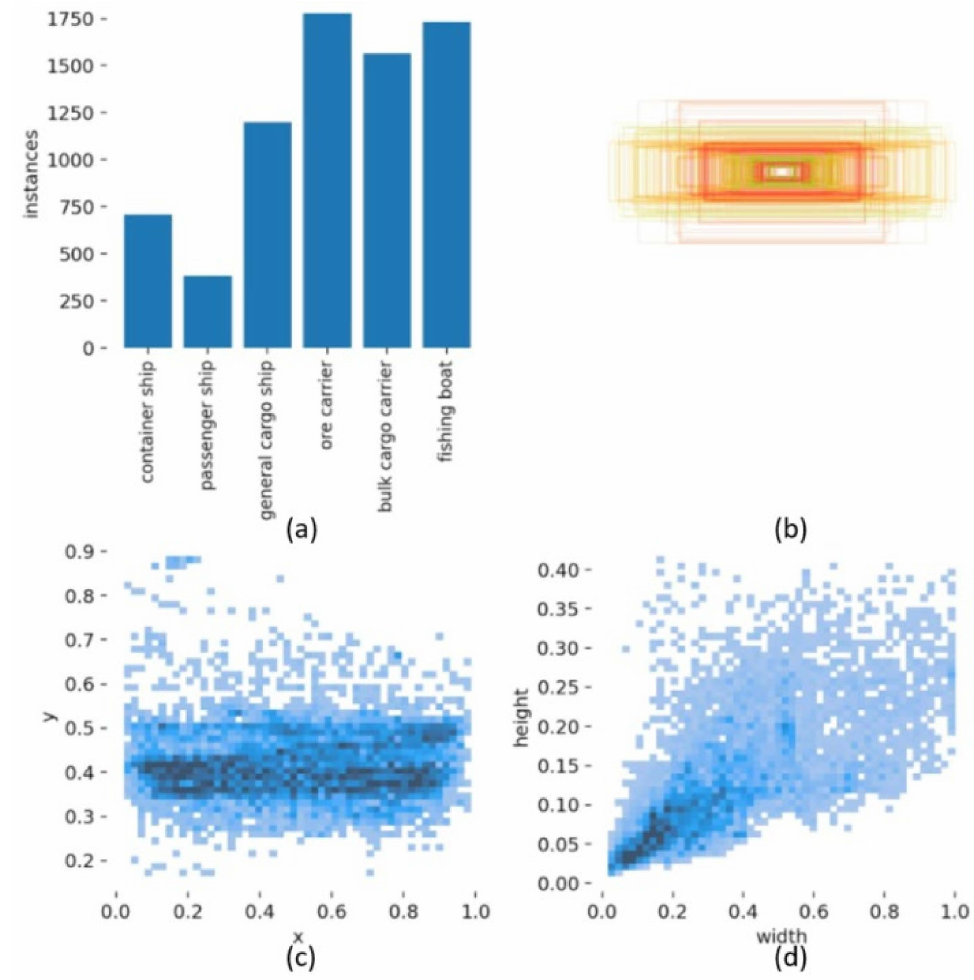
Figure 2. Distribution of Anchor information of a ship dataset. ( a ) Number of ships by class. ( b ) Statistics of Anchor shape. ( c ) Statistics of anchor X y center coordinates ( d ) Statistics of Anchor width